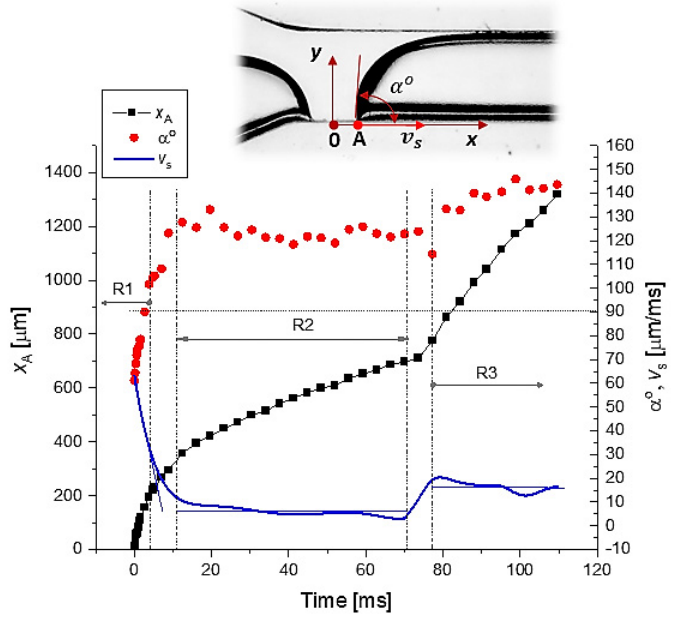
Figure 11. Kinematics after the breakup in the vicinity of space point A; see also Figure